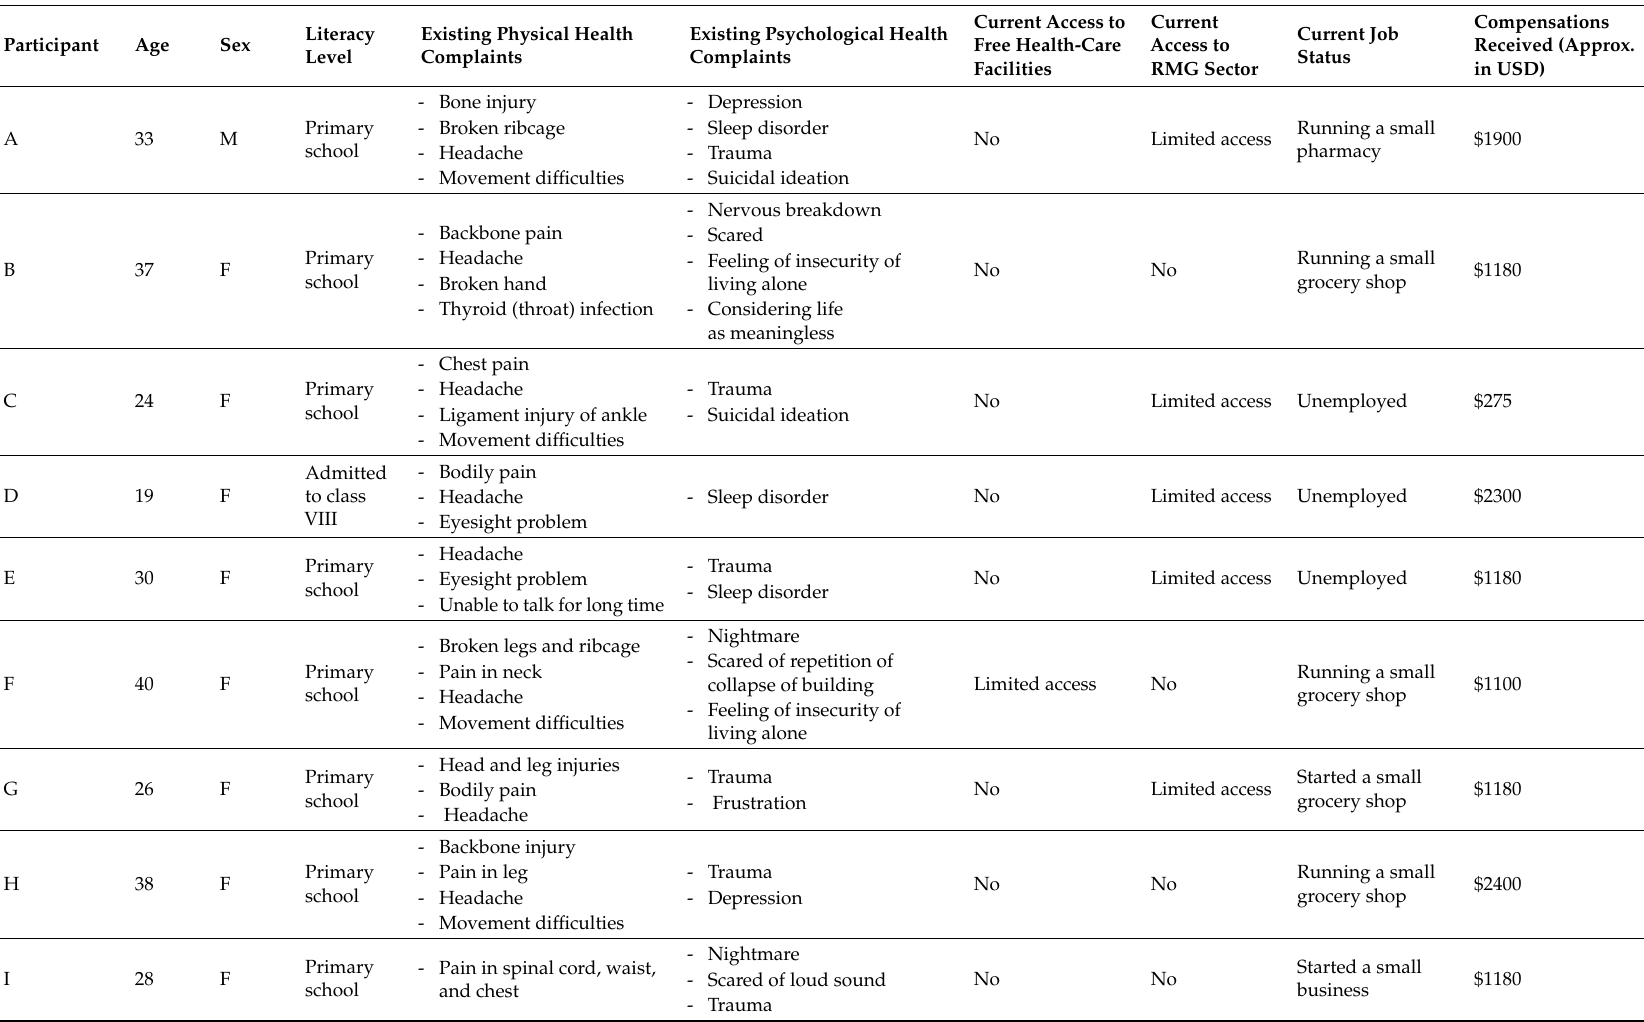
Table 1. Characteristics of the Rana Plaza survivors by existence health complaints, access to free healthcare facilities, current job status, and compensations. Participant Age Sex